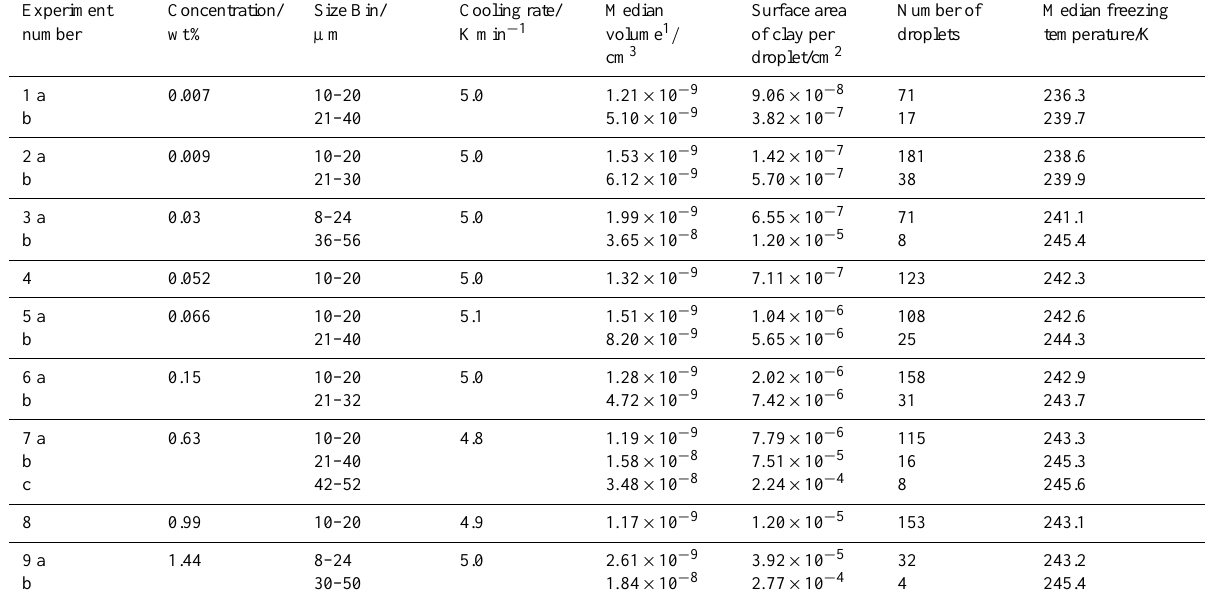
Table 2. Summary of experimental conditions for runs performed using a cooling rate of 5Kmin − 1 . Droplet distributions were split into size bins, which are labelled a, b and c. The median freezing temperatures for each run are also